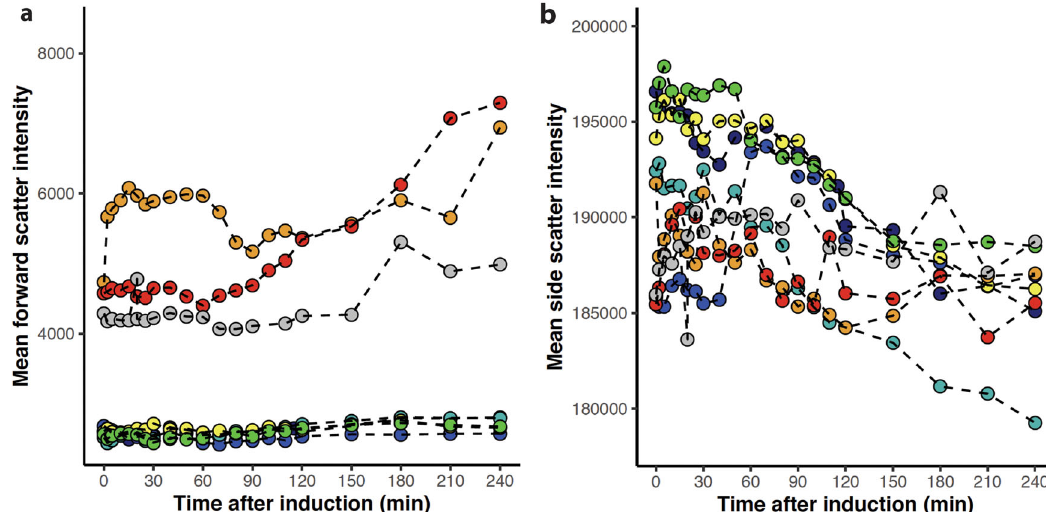
Fig. 8 Cell morphology of whole populations expressing N102LT variants. Forward ( a ) and side ( b ) scatter as a function of time for variants: L57G (dark blue), L57C (blue), L57P (cyan), M40A (green), Q33S (yellow), V36I (orange), Q33Y (red) and wt (grey). One of three replicates are shown for each variant.